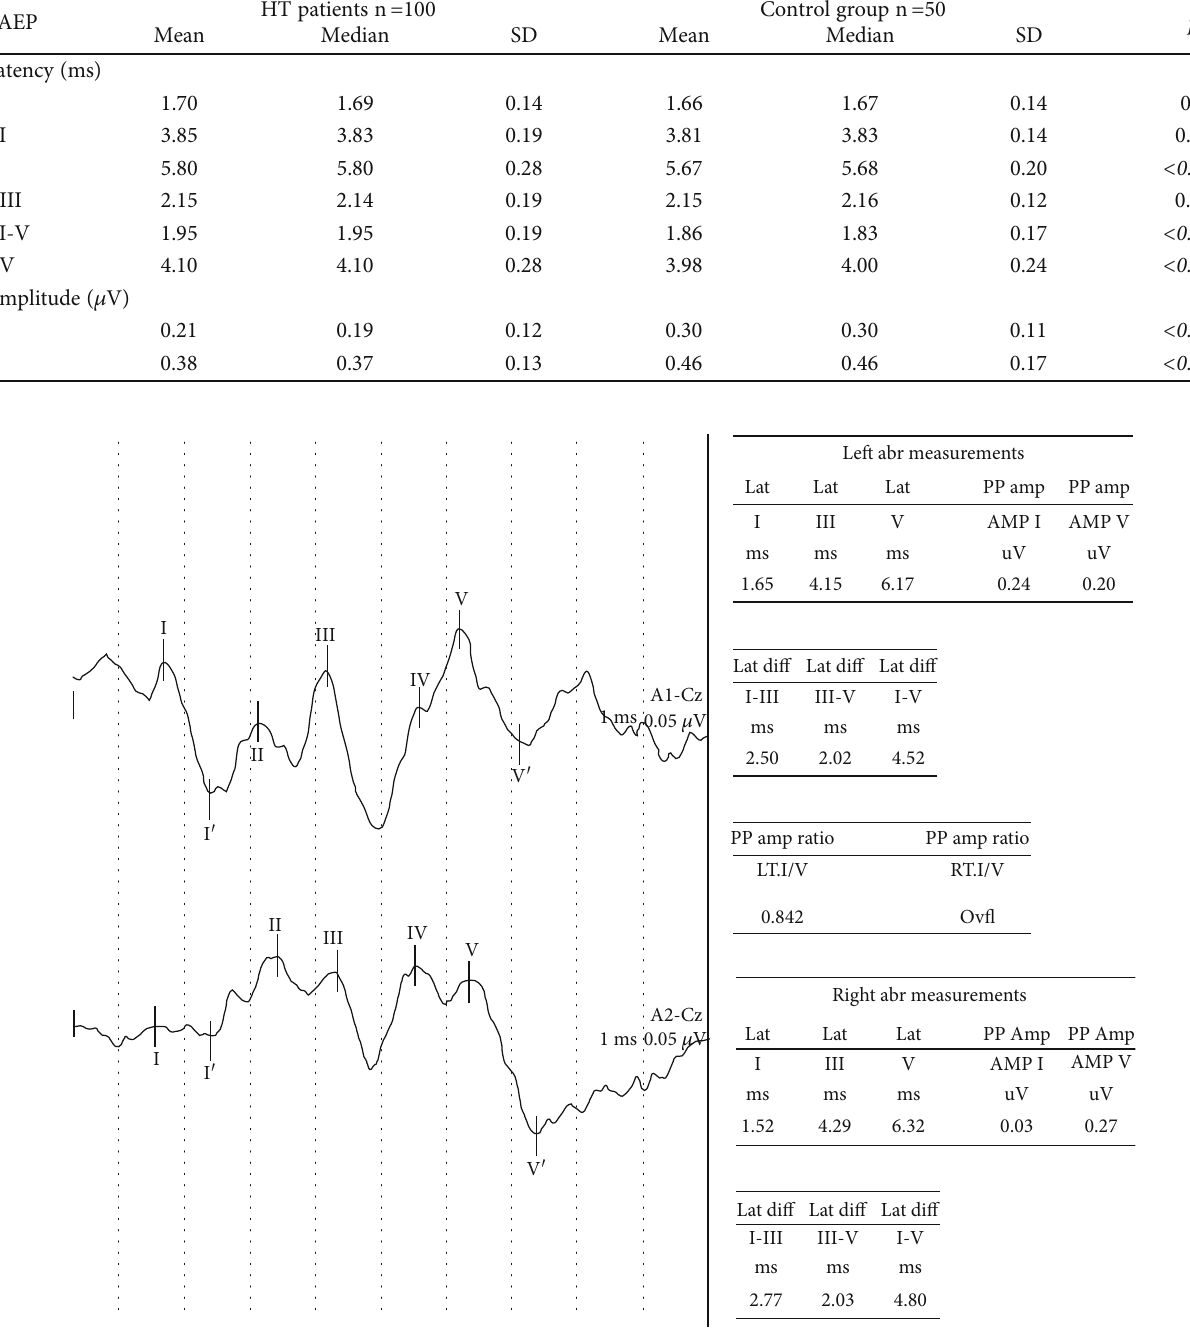
Figure 2: BAEP in HT male — prolonged latencies and interpeak latencies: III (L-4,15ms, R-4,29 ms), V (L-6.17ms, R-6,32ms), I-III (L-2,5ms, R-2,77 ms) and I-V (L-4,52ms, R-4,8